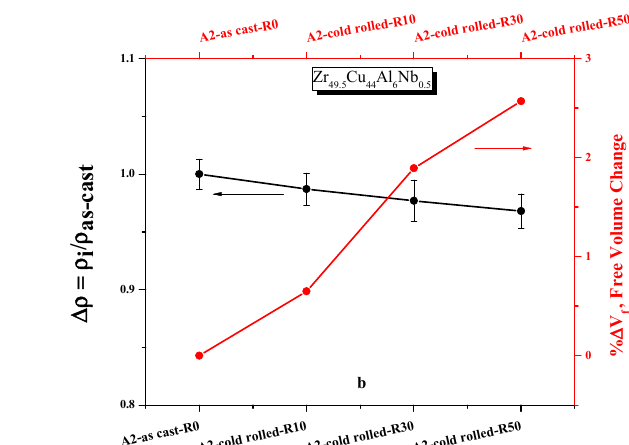
Figure 5. Micro-hardness of samples at different plastic strains.